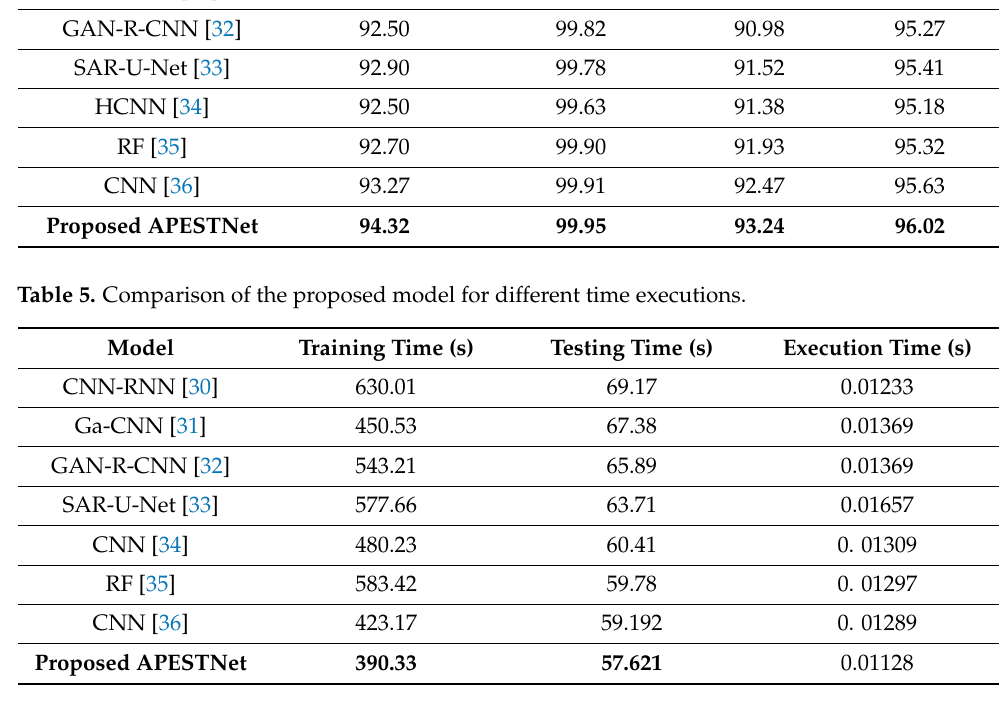
Table 5. Comparison of the proposed model for different time executions.